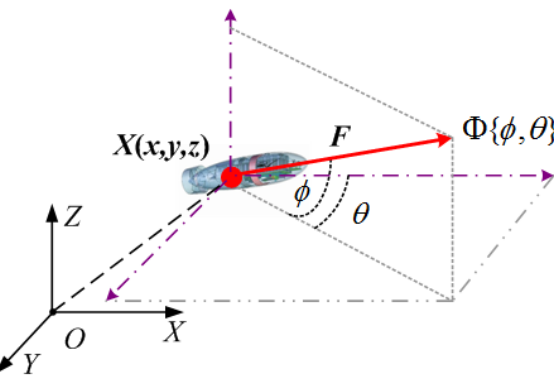
Figure 2. AUV and its motion heading in 3D Cartesian space.